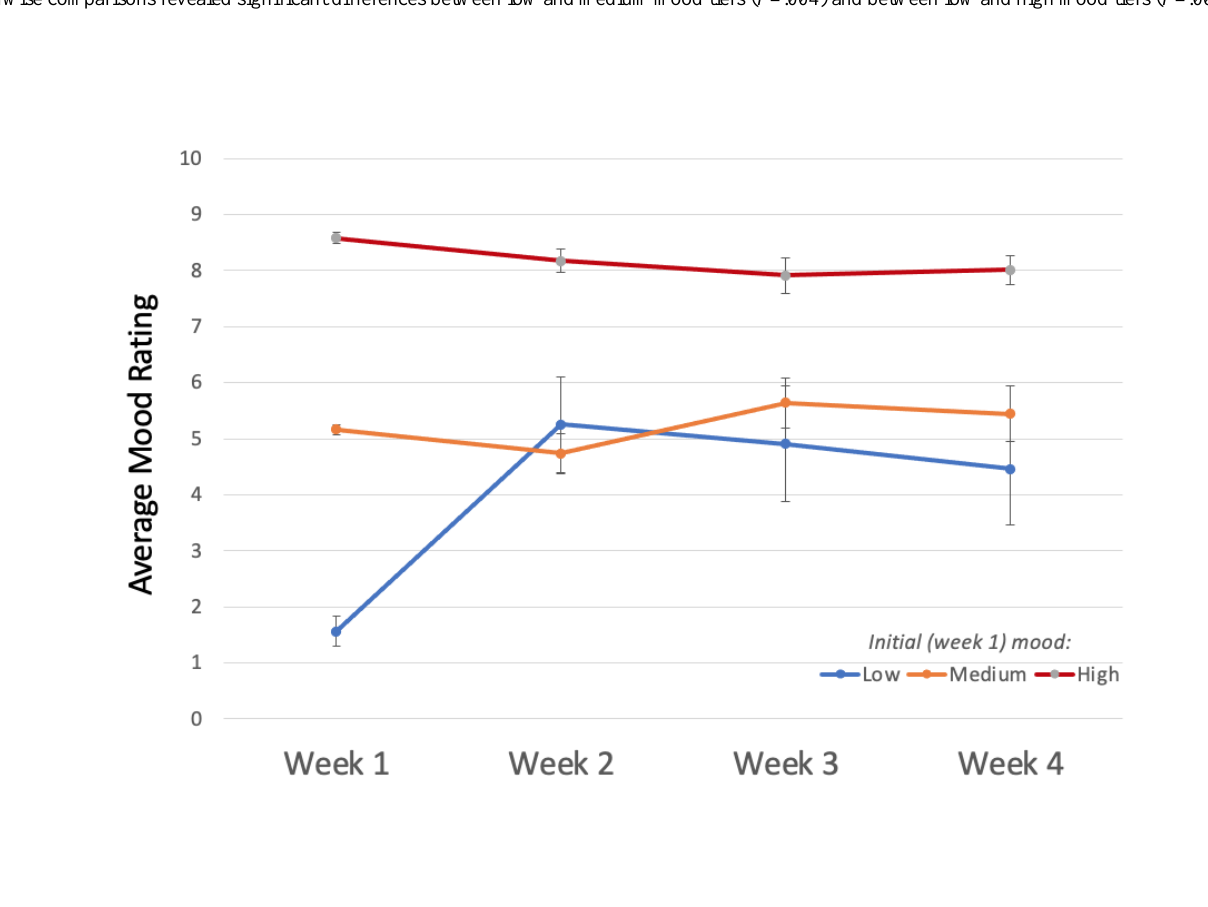
Figure 3. Change in mood from week 1 to week 4 of the intervention ( δ ) for participants varied significantly across mood tiers [H(2)=14.85; P <.001]. Pairwise comparisons revealed significant differences between low and medium mood tiers ( P =.004) and between low and high mood tiers ( P